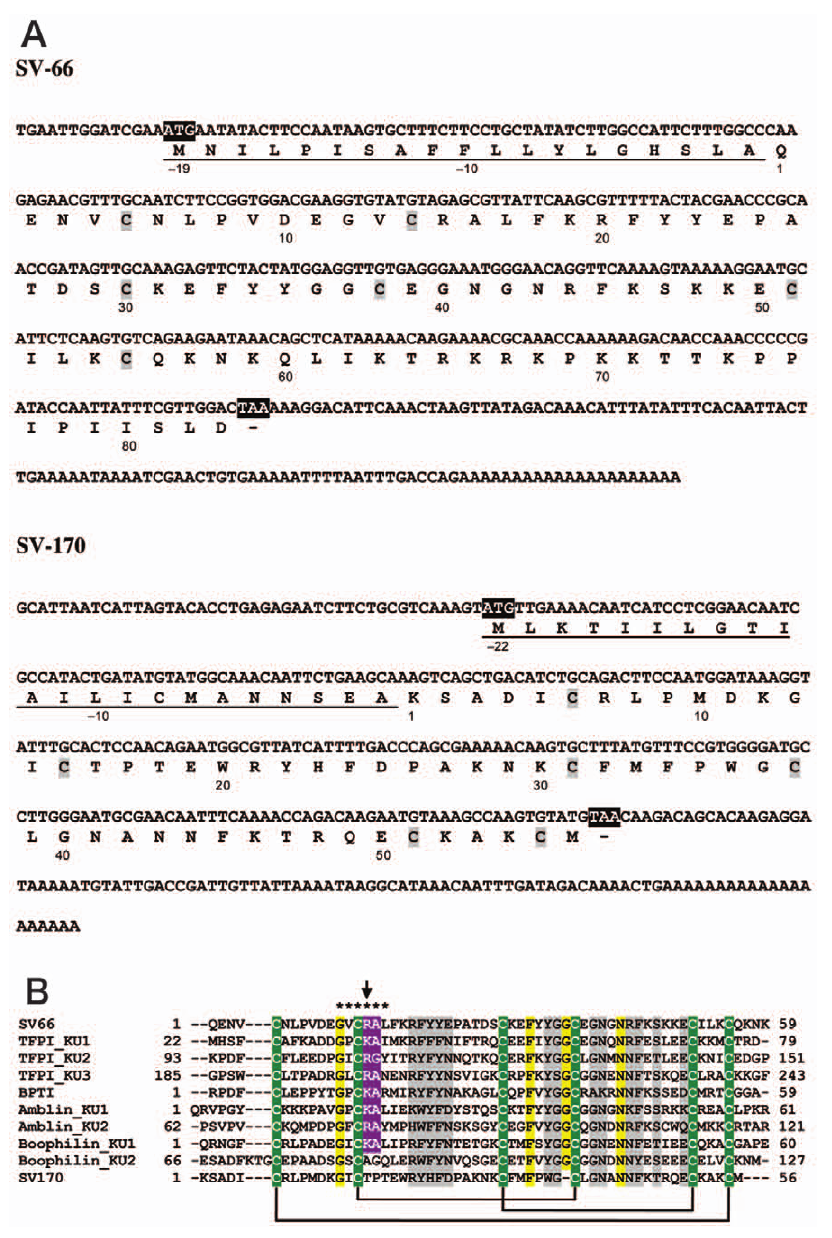
Figure 1. SV-66 and SV-170 belong to the Kunitz family of protease inhibitors. (A) Nucleotide and translated polypeptide sequences of SV- 66 and SV-170. Start and stop codons are in white with black shading. Numbers below the amino acid residues are designated based on the putative mature protein. Signal sequences predicted by SignalP are underlined. Top: SV-66 encodes a 102 amino-acid polypeptide (Simukunin), which includes a 19 amino-acid N-terminal signal sequence. Mature Simukunin is predicted to consist of 83 amino-acid residues, with a theoretical mass of 9627.22 Da and pI of 9.93. SV-66 also contains a putative O-glycosylation site at position 81 (Ser). Bottom: SV-170 encodes a 78 amino-acid polypeptide, which includes an N-terminal 22 amino-acid signal sequence. Mature SV-170 is predicted to consist of 56 amino-acid residues, and theoretical mass and pI are 6526.66 Da and 8.87, respectively. (B) Alignment of representative Kunitz domain sequences with SV-66 and SV-170. Each Kunitz domain was separated from the original sequences for alignment (numbers denote amino-acid positions in the original mature peptides). All reference sequences were retrieved from GenBank. Accession numbers are: TFPI (human: 3 Kunitz domains), P10646; BPTI ( Bos taurus : 1 Kunitz domain), AAI49369; Amblin ( Amblyomma hebraeum : 2 Kunitz domains), AAR97367; Boophilin ( Rhipicephalus microplus : 2 Kunitz domains), CAC82583. Strictly conserved cysteine residues are white with green shading, and predicted conserved disulfide bonds are shown in solid lines. The reactive site loop (RSL) P 4 -P 2 9 residues, conserved in canonical binding inhibitors, are indicated by asterisks. The P 1 residue is indicated with an arrow. Highly conserved P 1 -P 1 9 (Arg/Lys-Ala/Gly) residues are shown in white with purple shading. Other identical residues across the domain are shaded with yellow and conserved or semi-conserved residues are shaded with